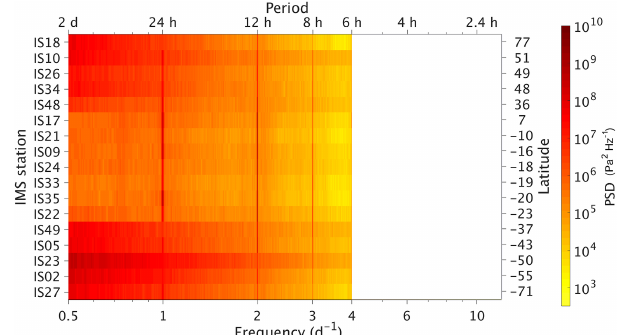
Figure A2. Median PSD spectrum of the MERRA-2 time series (analogue to Fig. 7). The period range is limited at 6h due to the sampling interval of MERRA-2 data (3h). The colour bar is slightly different from Fig. 7. The lunar semi-diurnal tide is not represented in MERRA-2 data.